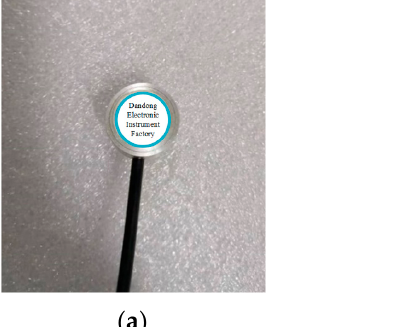
Table 2. Physical and mechanical indexes of test soil samples.